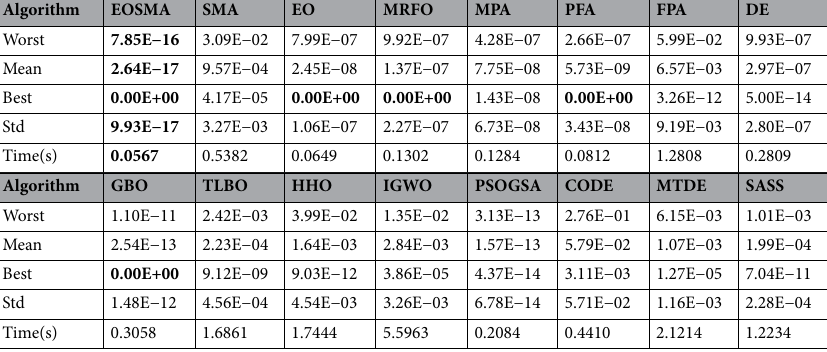
Table 5. Comparative results of inverse kinematics problem. The optimal values are shown in